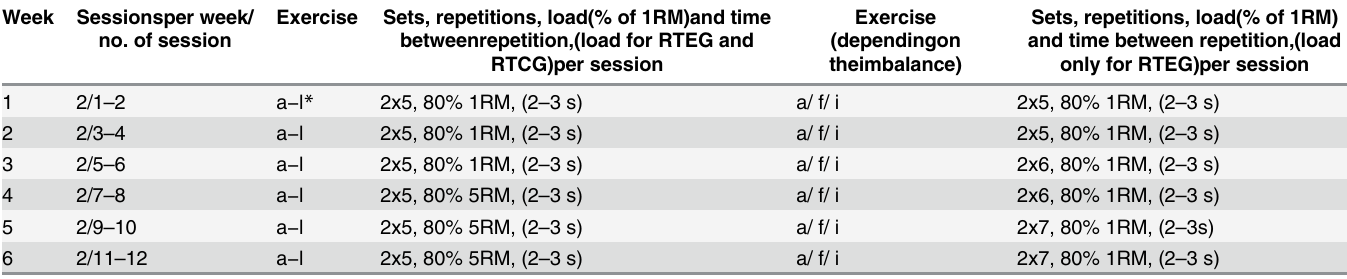
Table 2. Training protocol of the resistance training program for both groups.